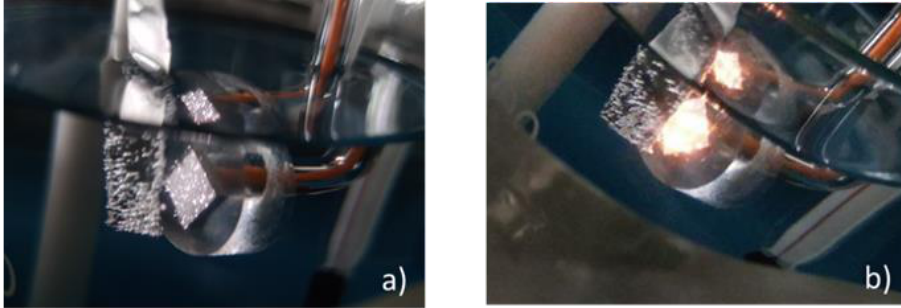
Figure 3. Micro-spark development during ( a ) the second step and ( b ) the third step of the PEO treatment.